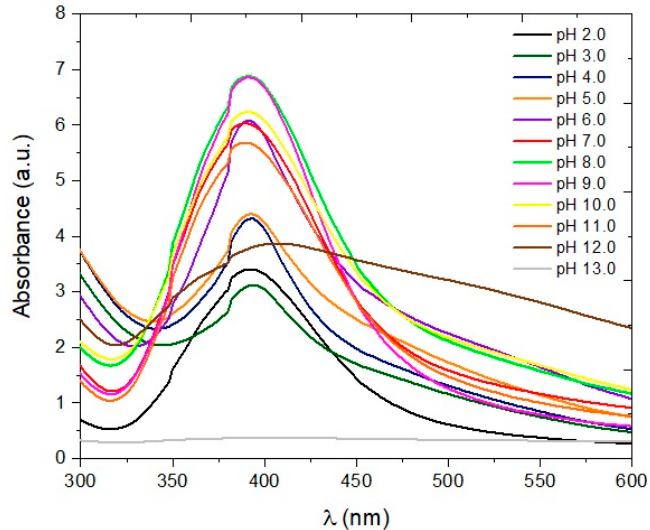
Figure 3. UV-Vis spectra of AgNPs synthesized at different pH values of sodium citrate solution.